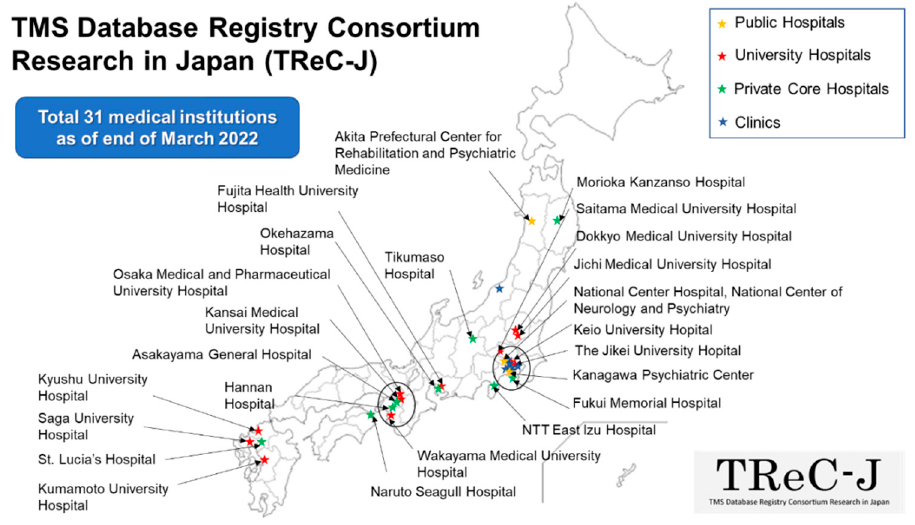
Figure 1. TMS Database Registry Consortium Research in Japan (TReC-J). As of March 2022, a total of 31 medical institutions throughout Japan are participating in this registry project. As marked by the black circles on the map, TMS facilities in Japan are concentrated in the Tokyo metropolitan area and in the Kansai area centered in Osaka.